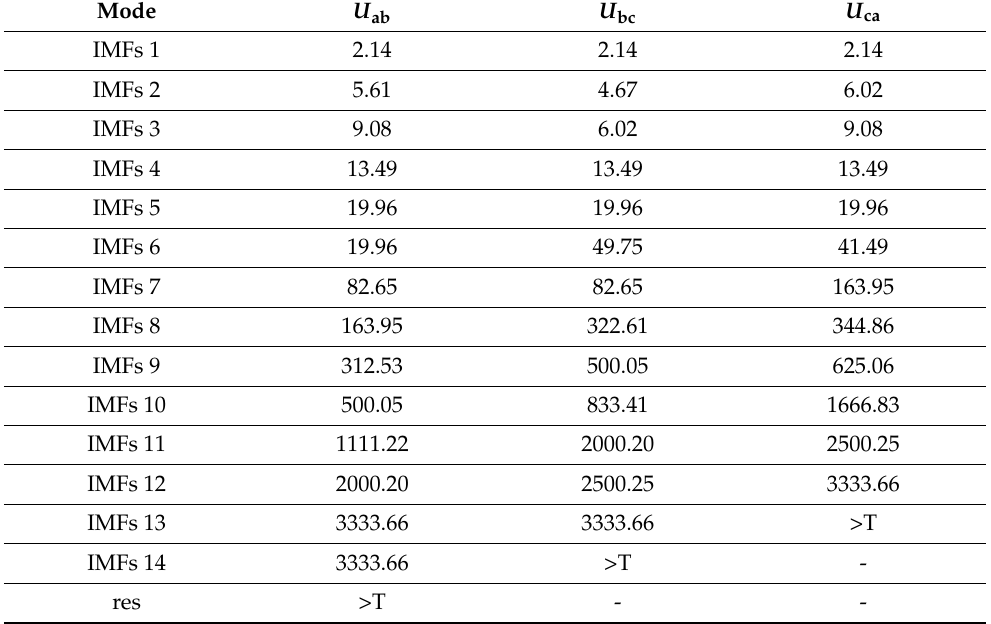
Table 4. The timescales of the common modes extracted by